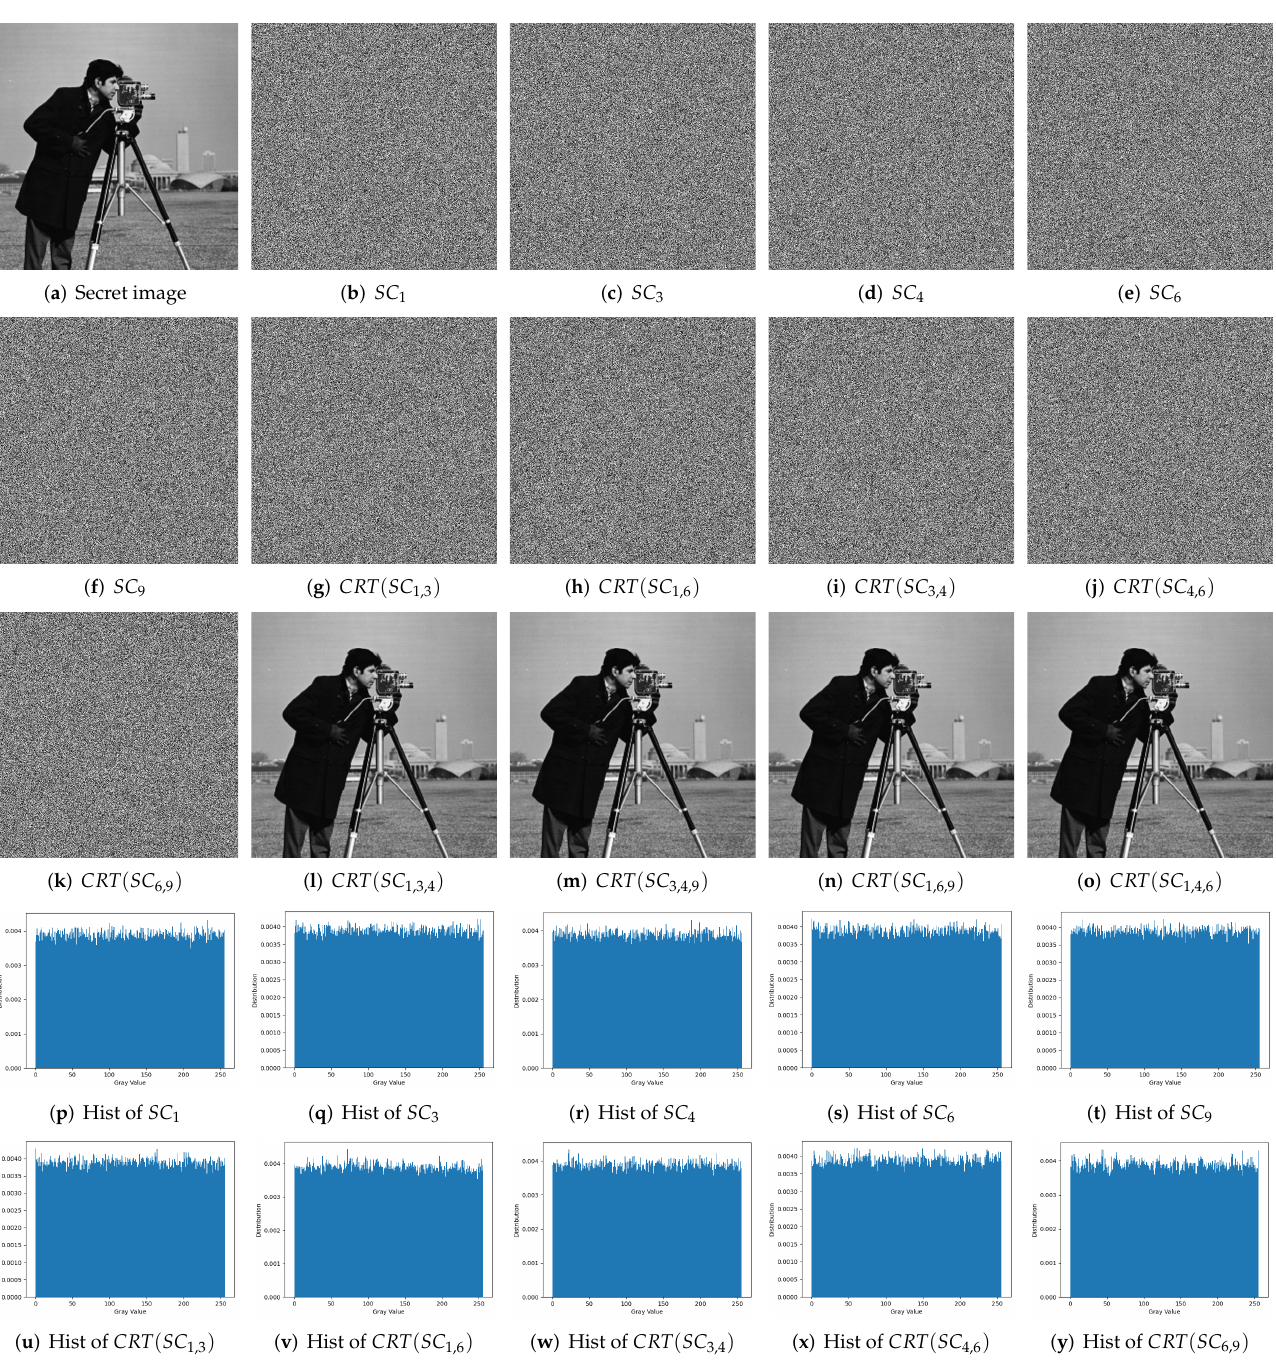
Figure 7. Experimental results of the introduced scheme for the ( 3,10 ) threshold. ( a ) Secret image; ( b – f ) five of the generated shares SC 1 , SC 3 , SC 4 , SC 6 and SC 9 ; ( g – k ) five recovered images with two shares; ( l – o ) five recovered images with three shares. ( p – y ) ten corresponding